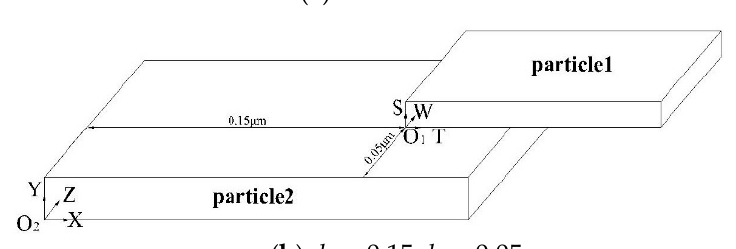
Figure 6. Two specific cases of face-face contact